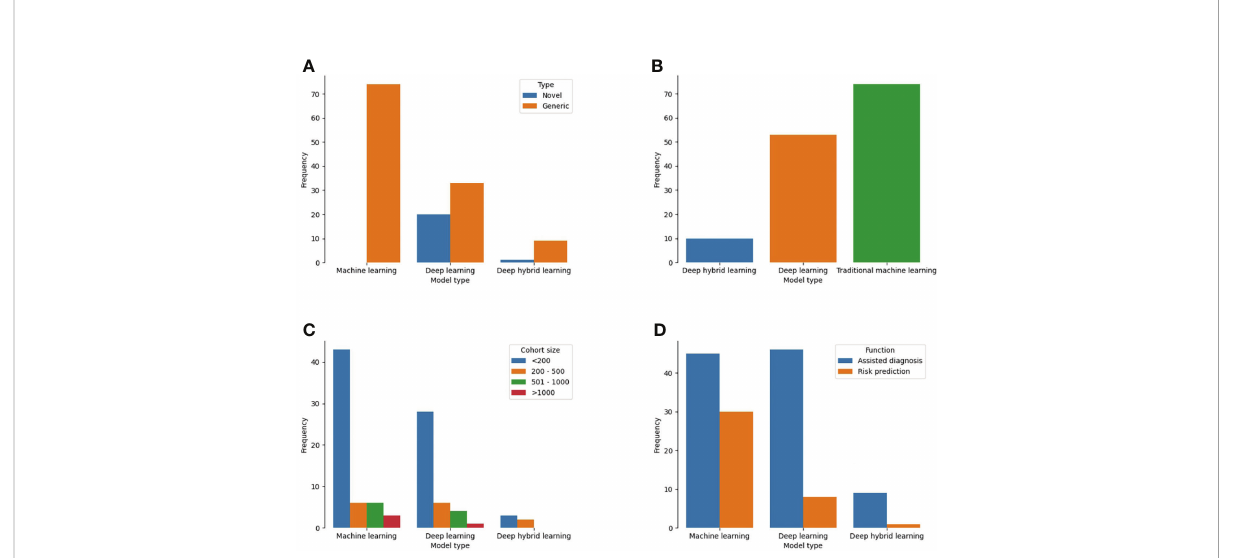
FIGURE 5 Plot showing the different techniques used for ML-based model construction for cancer patients in LLMICs (A) Model types (B) Novelty of backend algorithm used for model construction (C) Patient cohort size for model construction (D) Functions of the ML-based